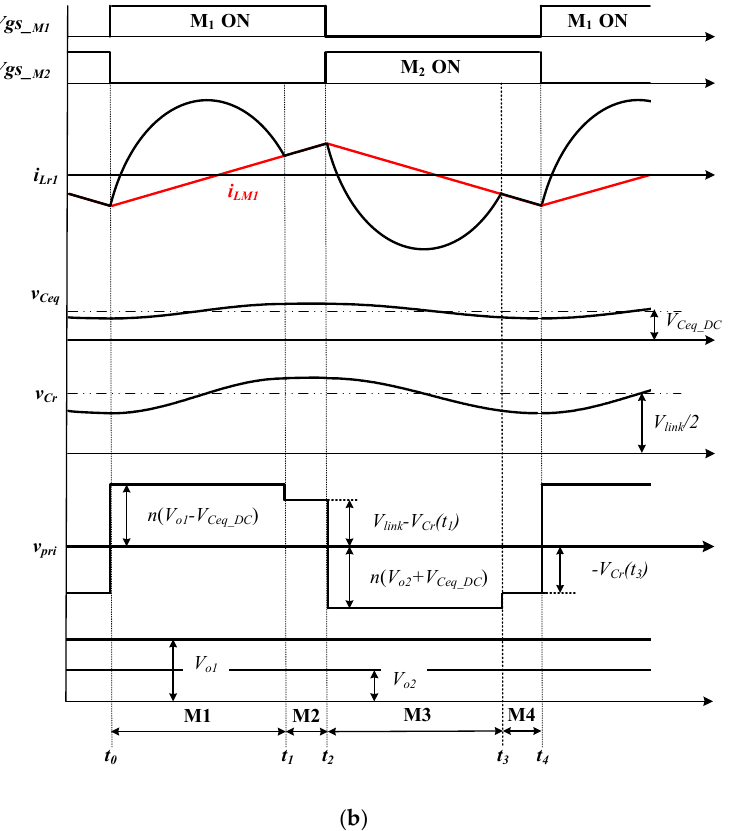
Figure 2. Proposed stacked single-ended LLC two channel LED driver: ( a ) Circuit diagram of the proposed circuit, ( b ) Key waveforms of the proposed circuit.